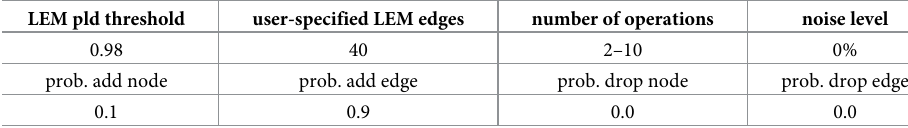
Table 4. Network finding hyperparameters for synthetic